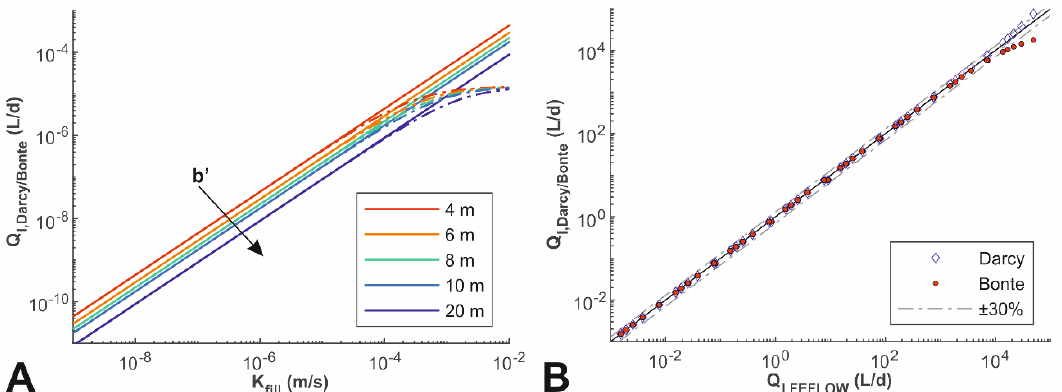
Figure 4. Comparison between the leakage flow rate values: ( A ) calculated with the formulas of Darcy (Equation (1)) (continuous lines) and Bonte (Equation (2)) (dashed lines), in the conditions simulated in this work; ( B ) resulting from simulations conducted with FEFLOW and from the analytical formulas of Darcy (green diamonds) and Bonte (magenta dots).